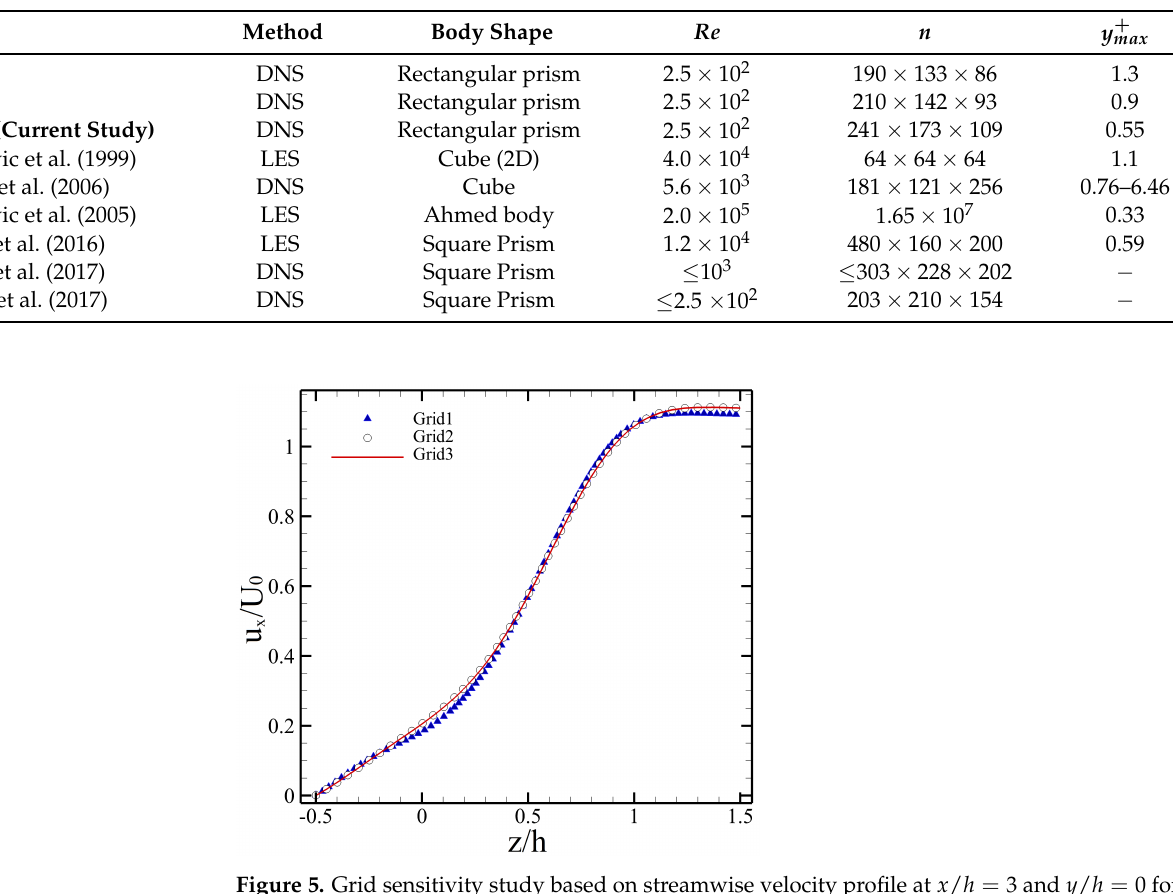
Table 1. Numerical setup comparison between current and previous studies. n is the number of elements. The bold case is used for the simulations.